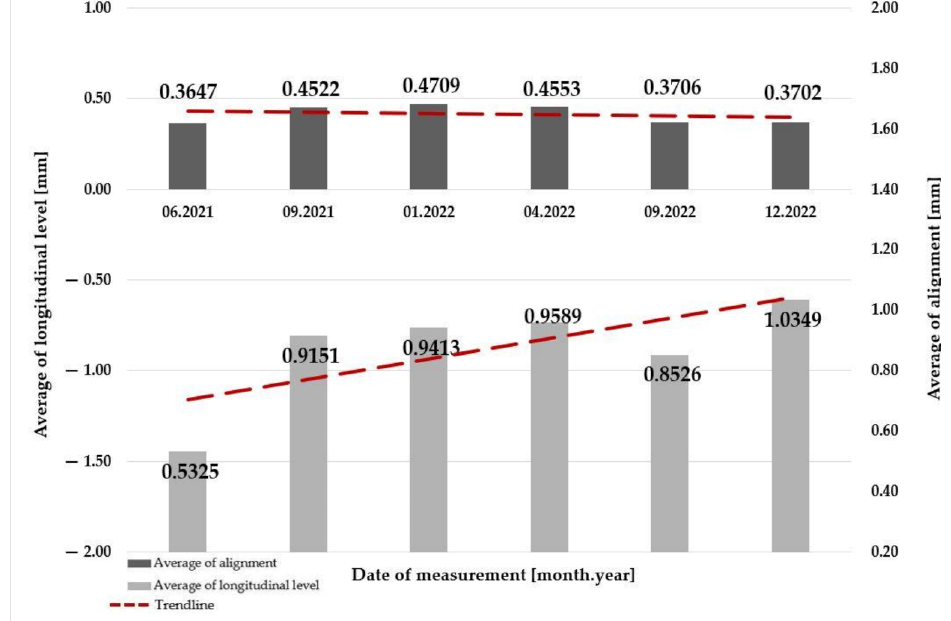
Figure 21. The change of average values of longitudinal level and alignment in Section